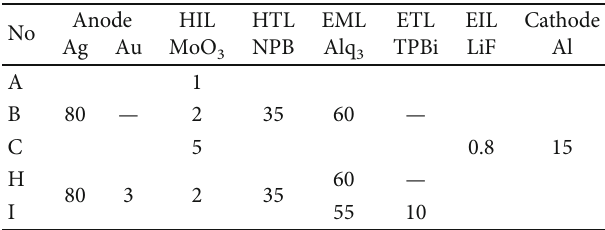
Table 3: Variable TE-OLED structure parameters for each layer thickness (unit: nm).